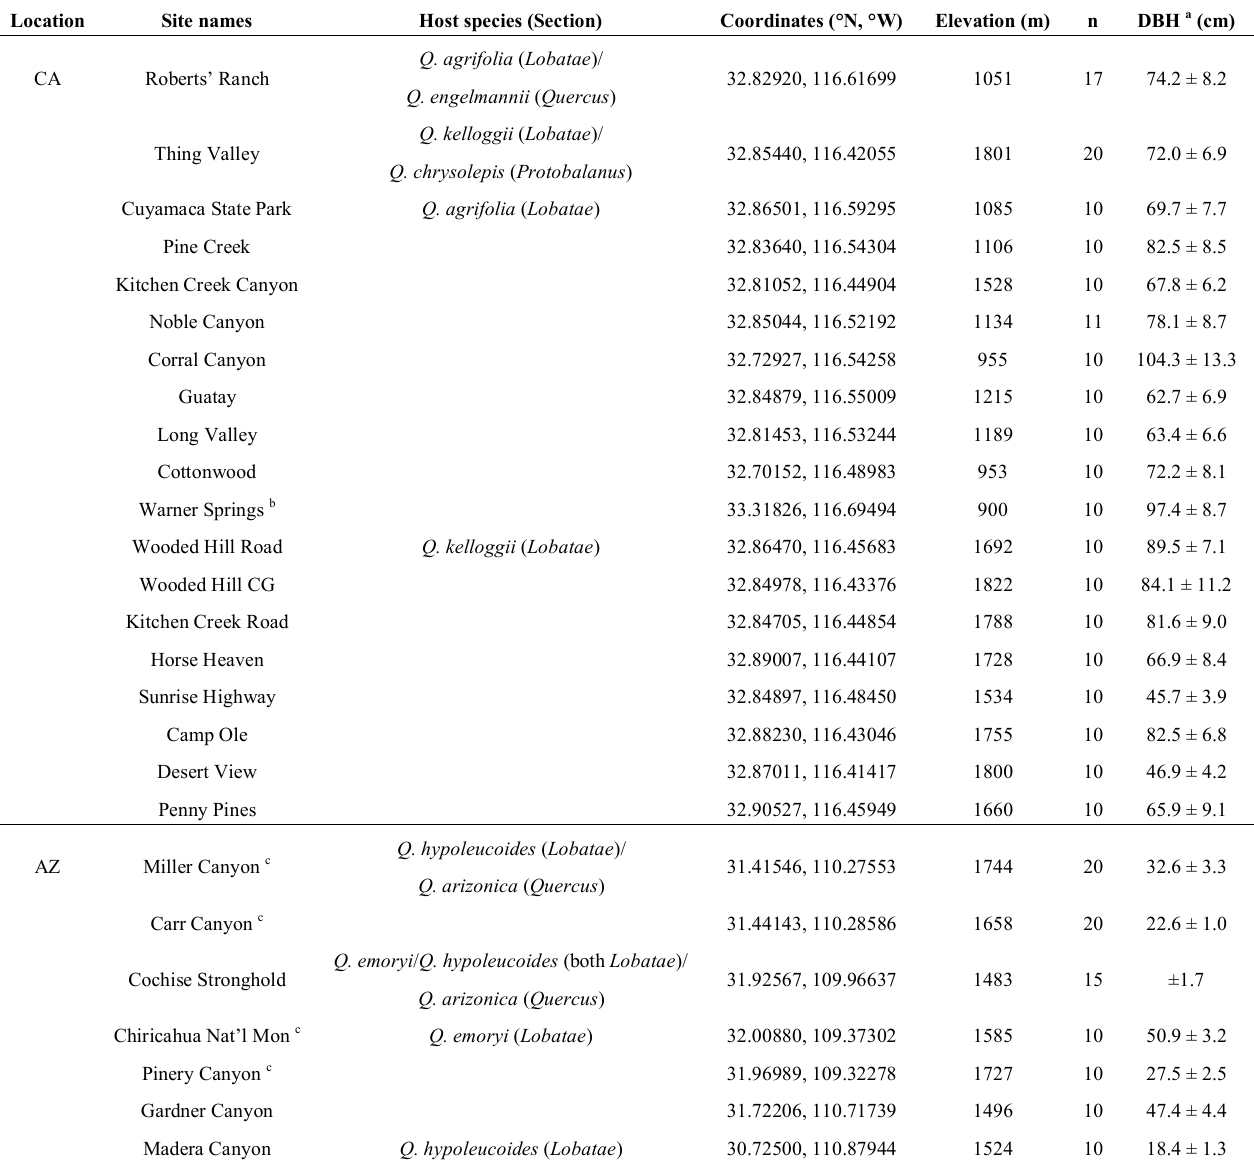
Table 1. Site information, tree sample sizes (n) and tree size (diameter at breast height, DBH) by host species and taxonomic